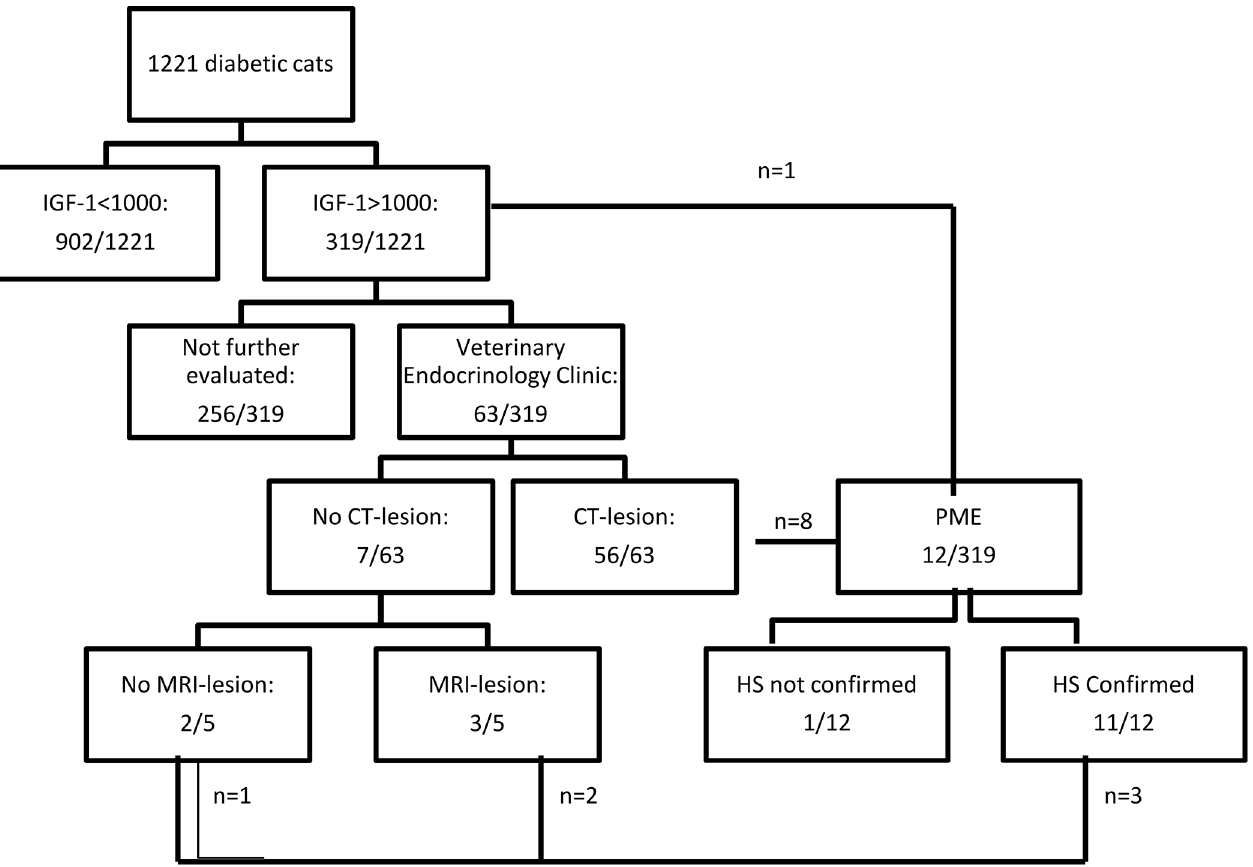
Fig 2. Overview of the screening results. In total 1221 cats with diabetes mellitus were screened for HS; the results are summarised in this figure. IGF-1: insulin-like growth factor-1; CT: computed tomography; MRI: magnetic resonance imaging; HS: hypersomatotropism; n: number of animals; PME: post- mortem